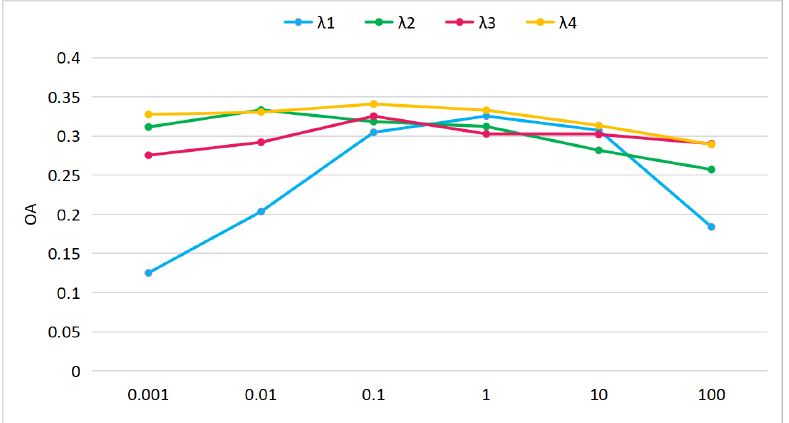
Figure 4. The sensitivity analysis of the weight factor assigned to the different